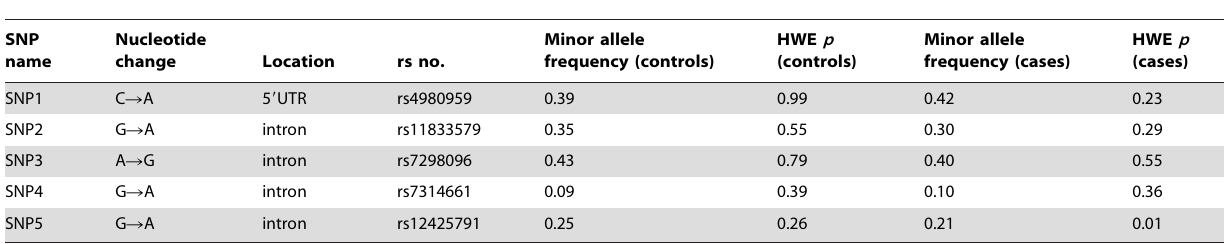
Table 2. Characteristics of NINJ2 haplotype tagging SNPs.